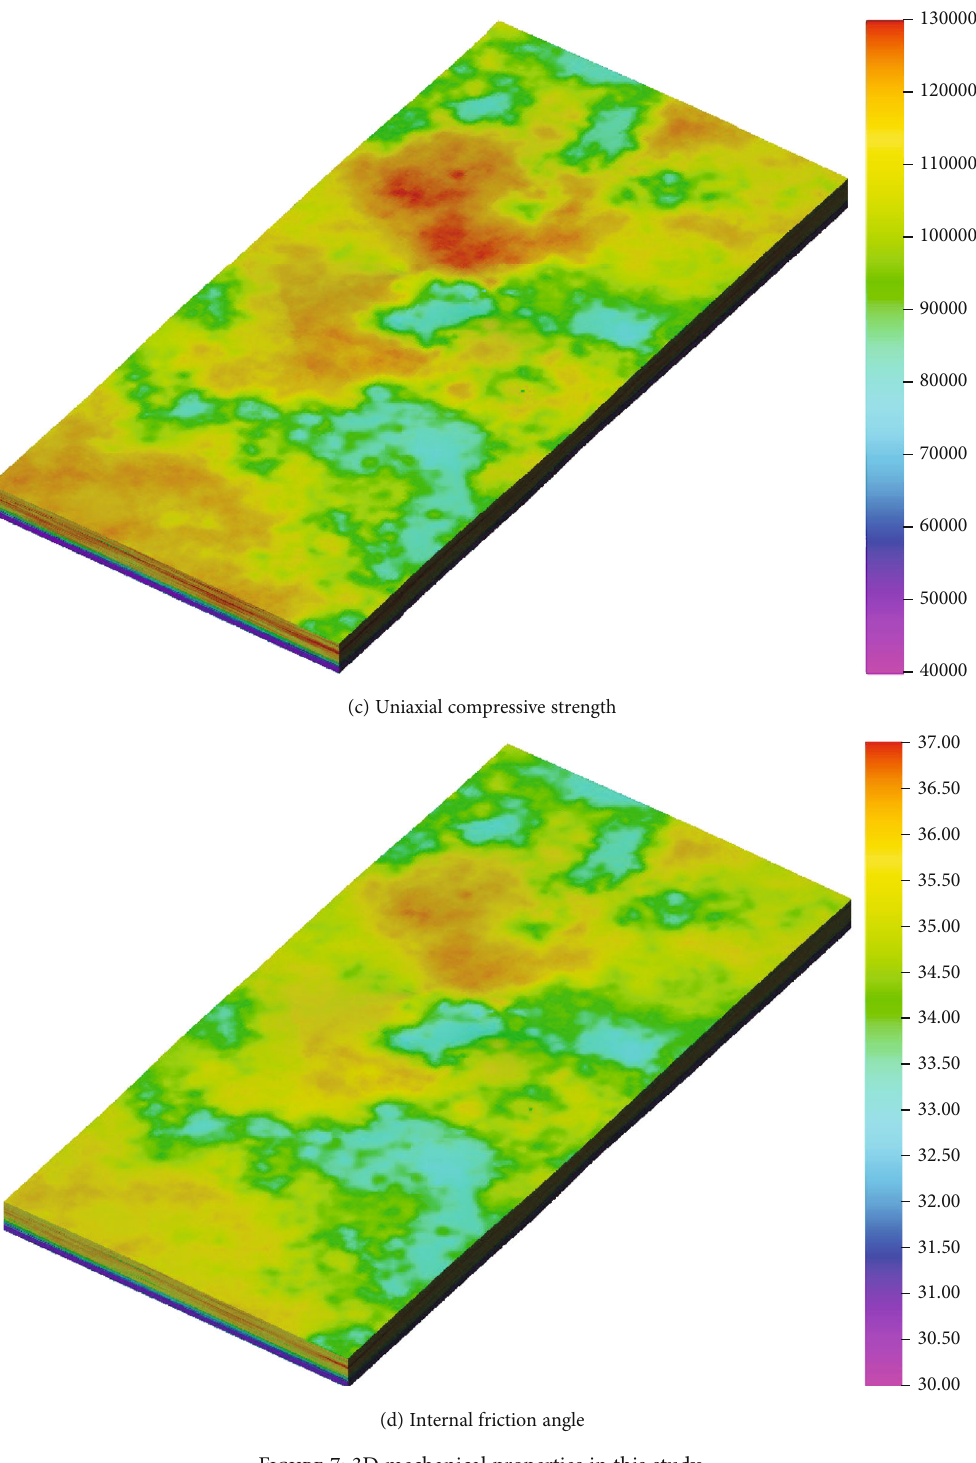
Figure 7: 3D mechanical properties in this